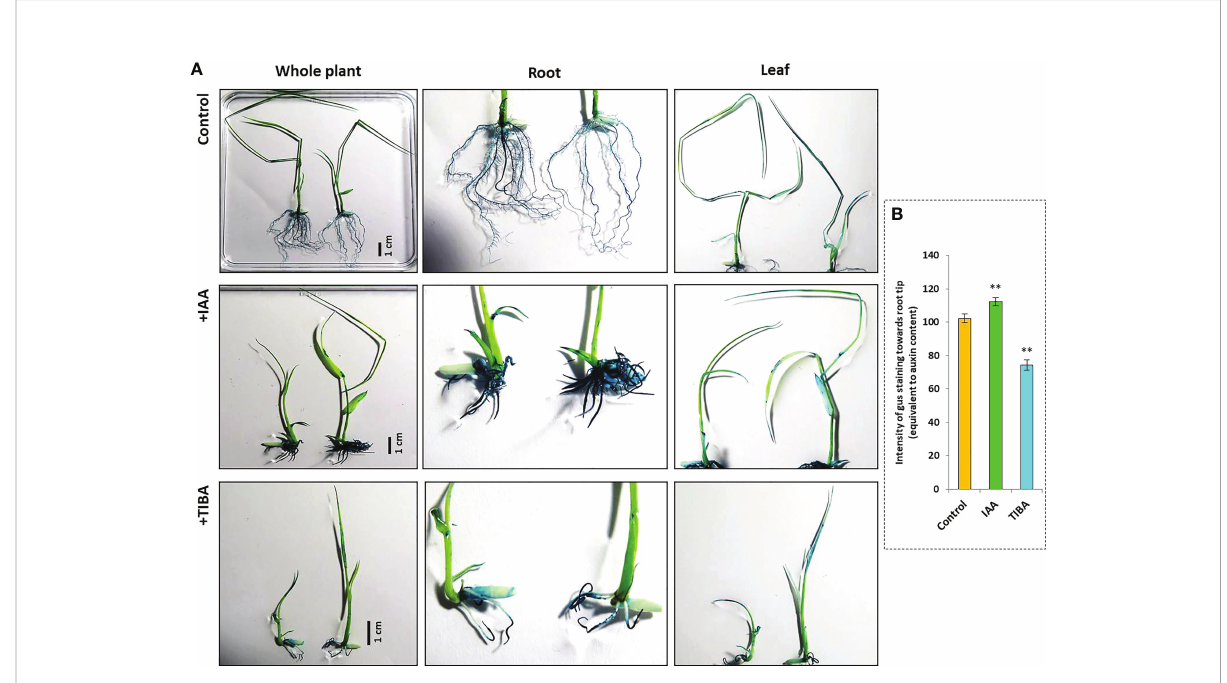
FIGURE 8 Gus staining of rice seedlings harboring gus gene under the control of the auxin-responsive DR5 promoter. (A) The rice seeds were germinated and grown over half MS medium containing 4 mg/L IAA or 8 mg/L TIBA for a duration of 15 days following which gus staining was carried out. The intensity of gus stain depicts the level of auxin present inside the tissue. IAA-treated seedling roots stained the most. In TIBA-treated seedlings, the upper part of the roots was not stained, showing the disruption of auxin transportation from the root tip (the zone where auxin accumulates in the highest amount). (B) The intensity of gus staining in and around the root tip region under control, +IAA, and +TIBA conditions depicting the level of internal auxin in the root tissues. Asterisks (**) indicate differences statistically signi fi cant at 0.01 probability.